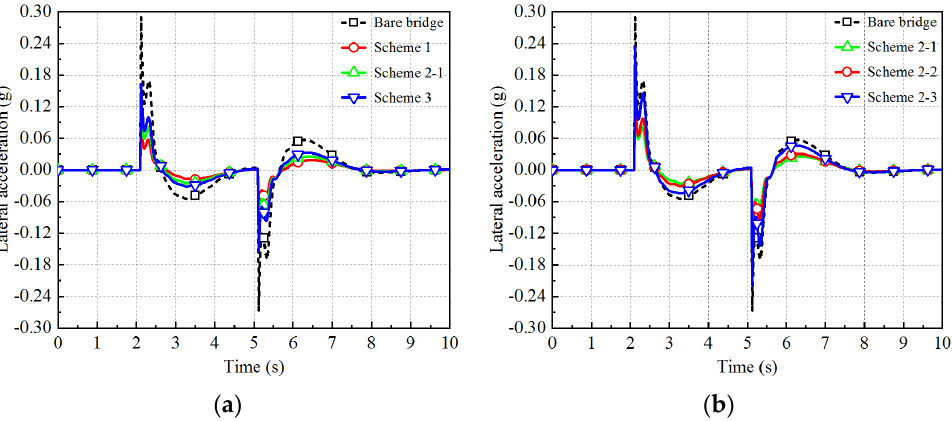
Figure 18. Lateral acceleration with different bridge wind barriers (( a ) Different porosity scheme; ( b ) Different height scheme). Figure 19 show the yaw velocity response curves under different working